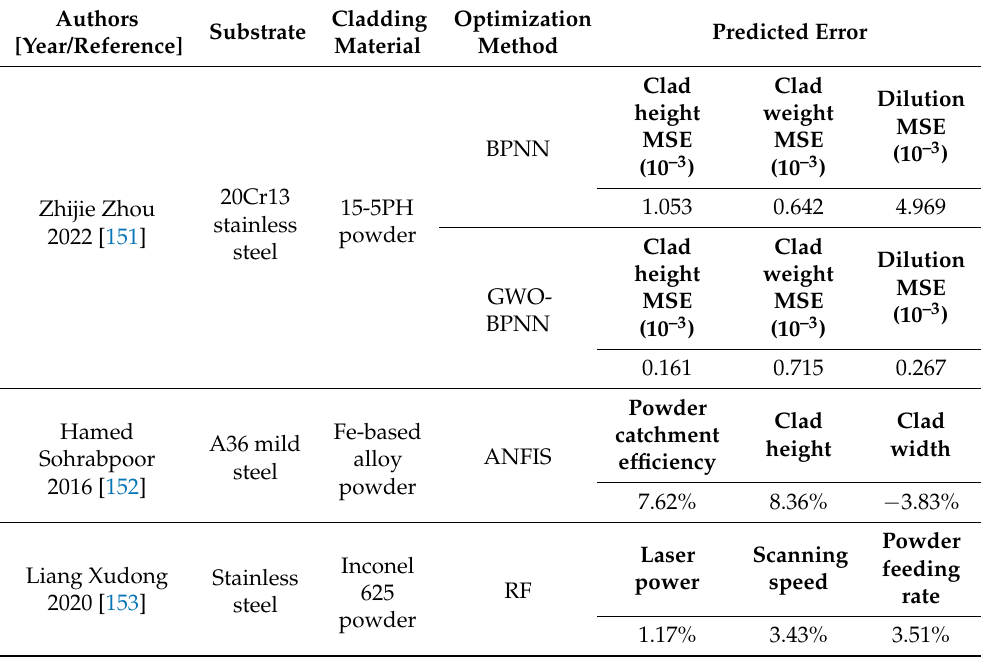
Table 7. The prediction results of ANFIS, RF optimization methods, and GWO optimization of